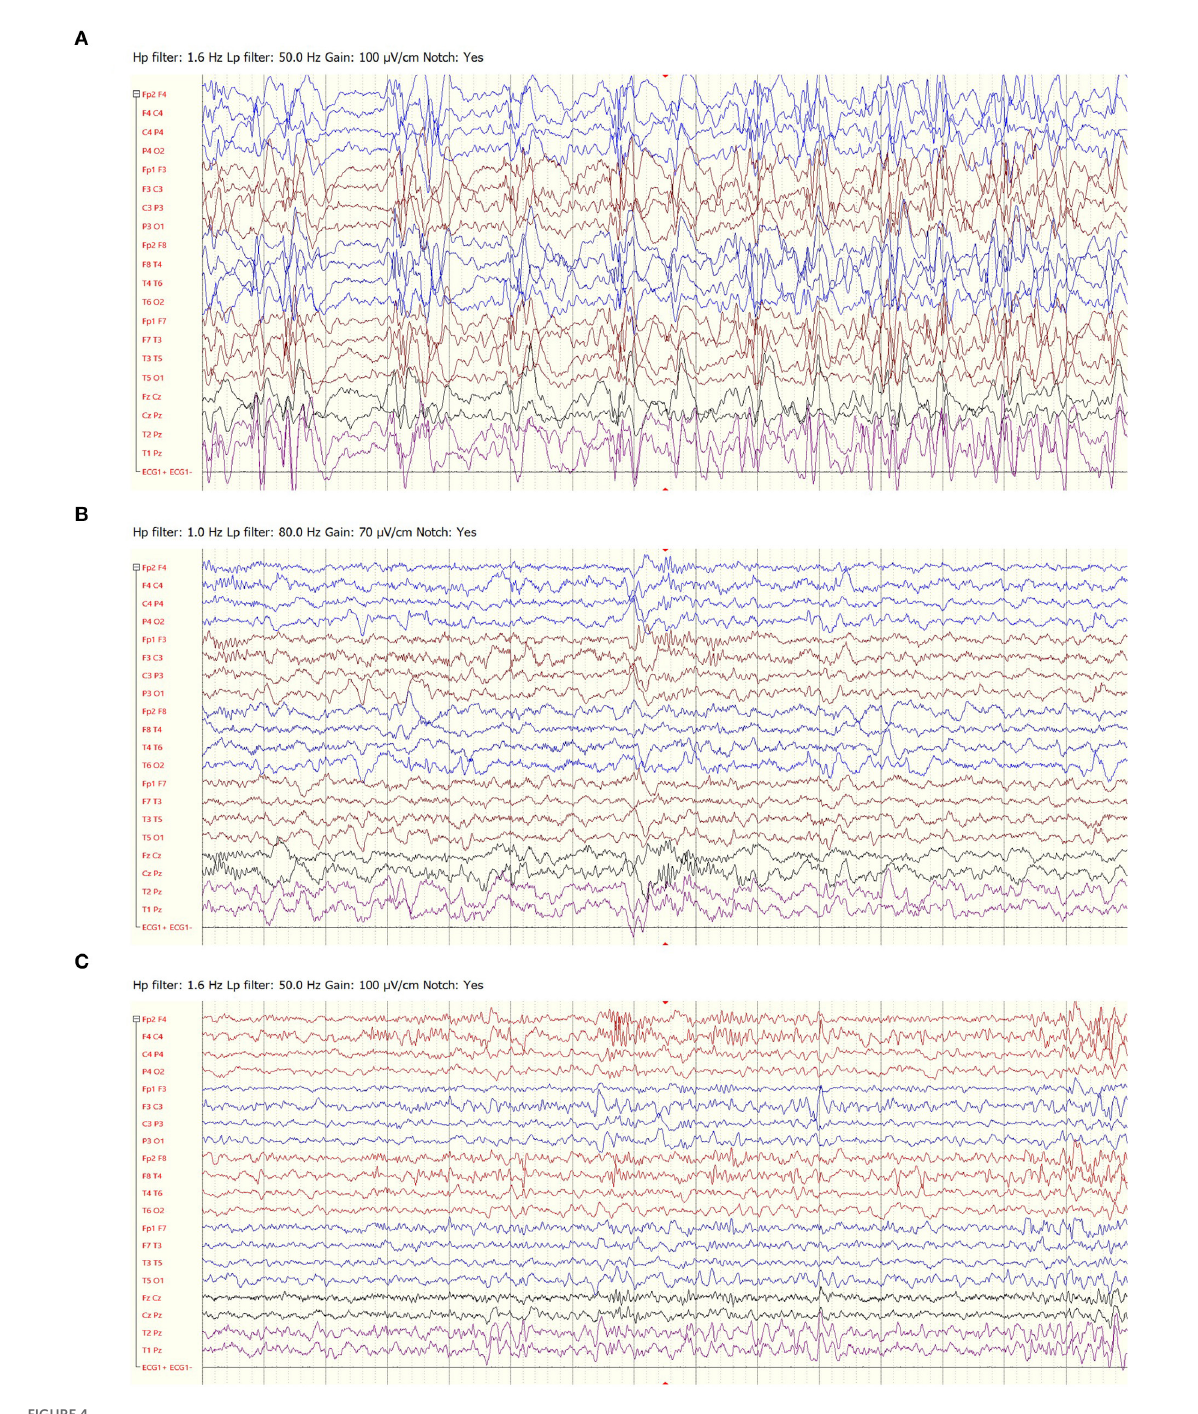
FIGURE4 EEG recordings of a 4-year-old girl with epilepsy following herpes encephalitis, prior to felbamate treatment (A) , following 3 months of treatment (B) and following 3 years of treatment (C)